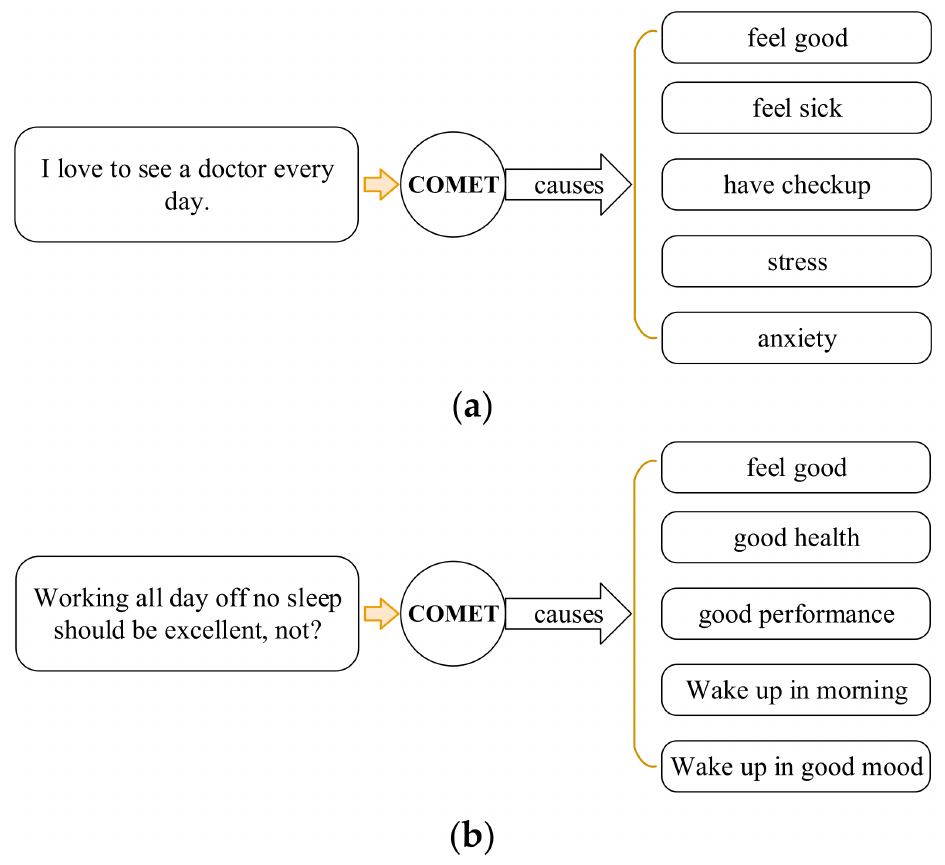
Figure 3. Examples of commonsense knowledge generation using COMET: ( a ) Effective common- sense knowledge; ( b ) Commonsense knowledge with a lot of useless